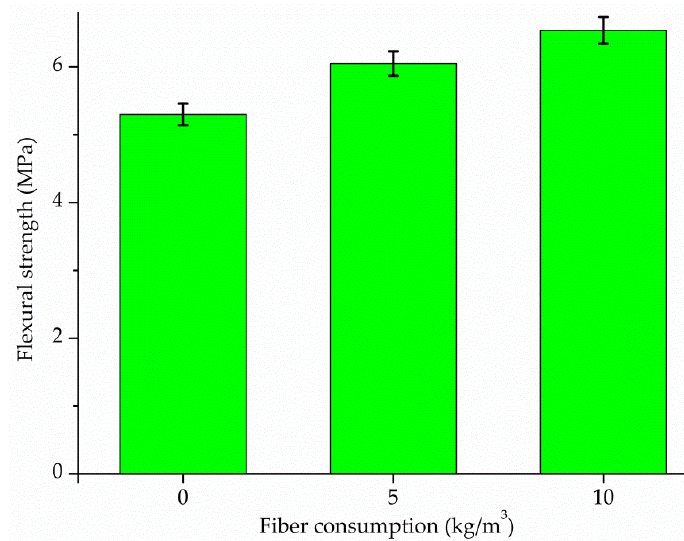
Figure 12. Flexural strength of the concrete with different fiber content.